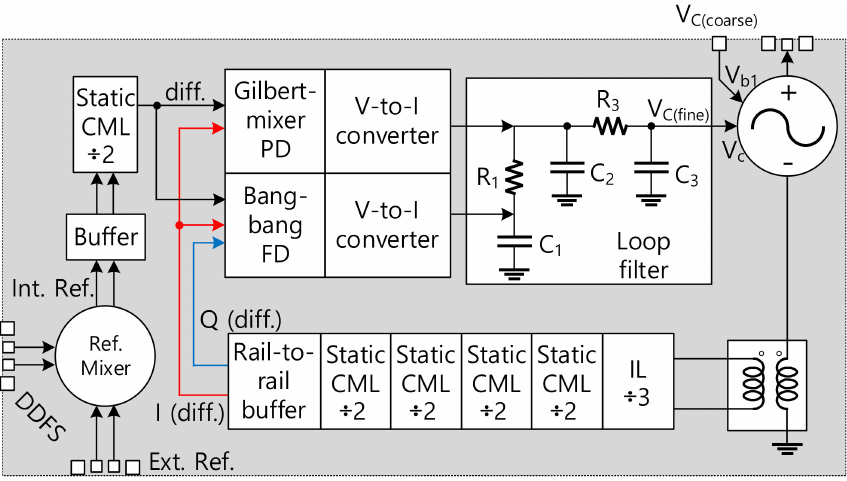
Figure 1. Block diagram of the implemented W-band